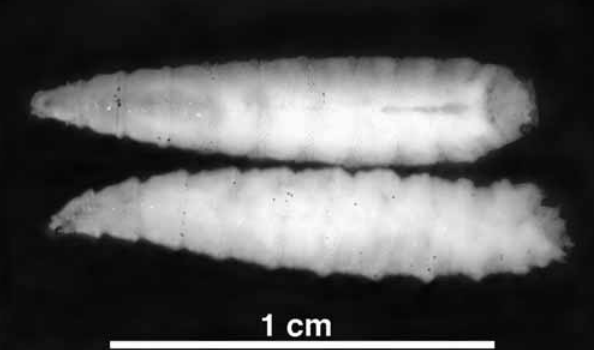
Figure 1) Maggot – Protophormia terraenovae Robineau-Desvoidy. Photograph provided by Danny Shpeley, BSc, Assistant Curator,